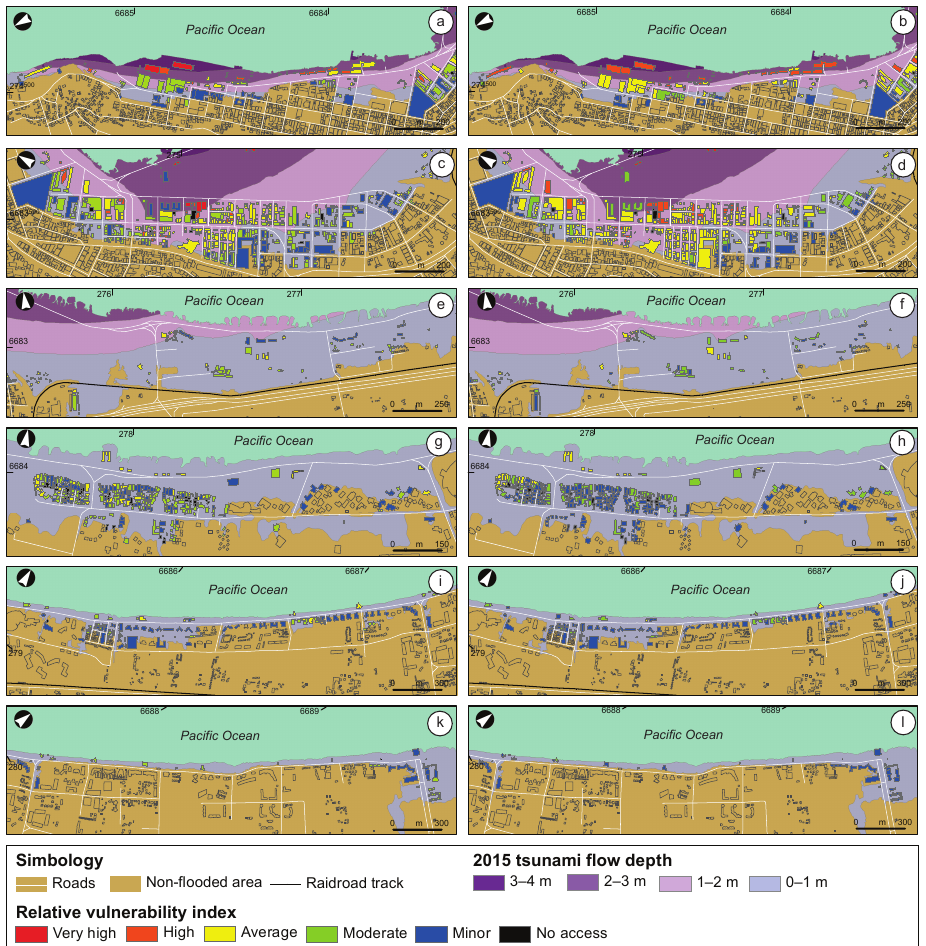
Figure 5. Relative vulnerability index for (a) sector 1 – Coquimbo Port PTVA-3 model; (b) sector 1 – Coquimbo Port PTVA-4 model; (c) sector 2 – Baquedano PTVA-3 model; (d) sector 2 – Baquedano PTVA-4 model; (e) sector 3 – La Cantera PTVA-3 model; (f) sector 3 – La Cantera PTVA-4 model; (g) sector 4 – Caleta Peñuelas PTVA-3 model; (h) sector 4 – Caleta Peñuelas PTVA-4 model; (i) sector 5 – La Pampa PTVA-3 model; (j) sector 5 – La Pampa PTVA-4 model; (k) sector 6 – La Serena PTVA-3 model; and (l) sector 6 – La Serena PTVA-4